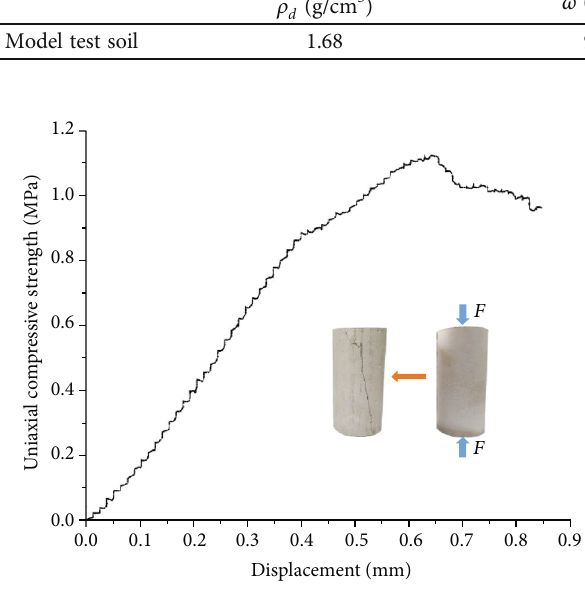
Figure 7: Uniaxial compressive strength of cylindrical sample with water, gypsum, and sand ratio of 1: